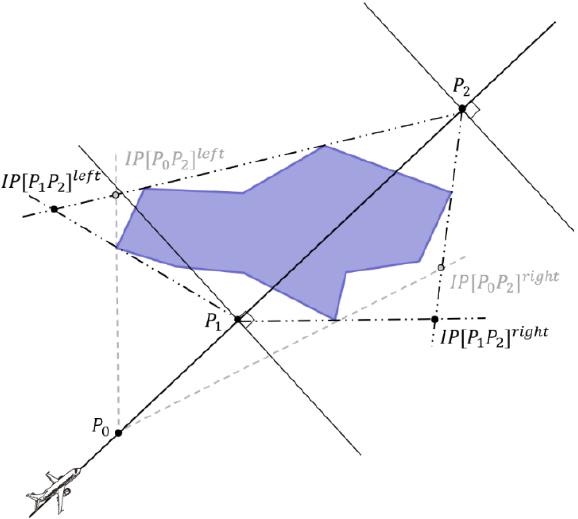
Figure 2. The principle of diversion route calculation. P 0 , P 1 , and P 2 are points outside a weather polygon and represent the possible start and end points of the diversion. All waypoints on the waypoint list between them will be dismissed. Additionally, selected diversion waypoints such as IP [ P 1 P 2 ] right will be integrated and used for 4D trajectory